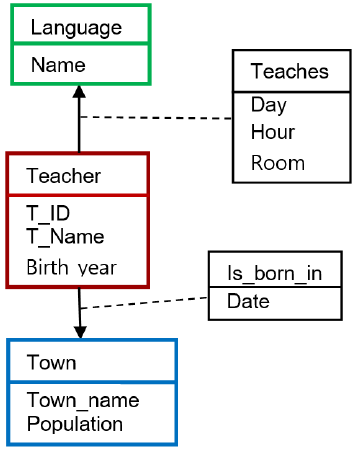
Fig. 9: Graph DB-schema 1 with